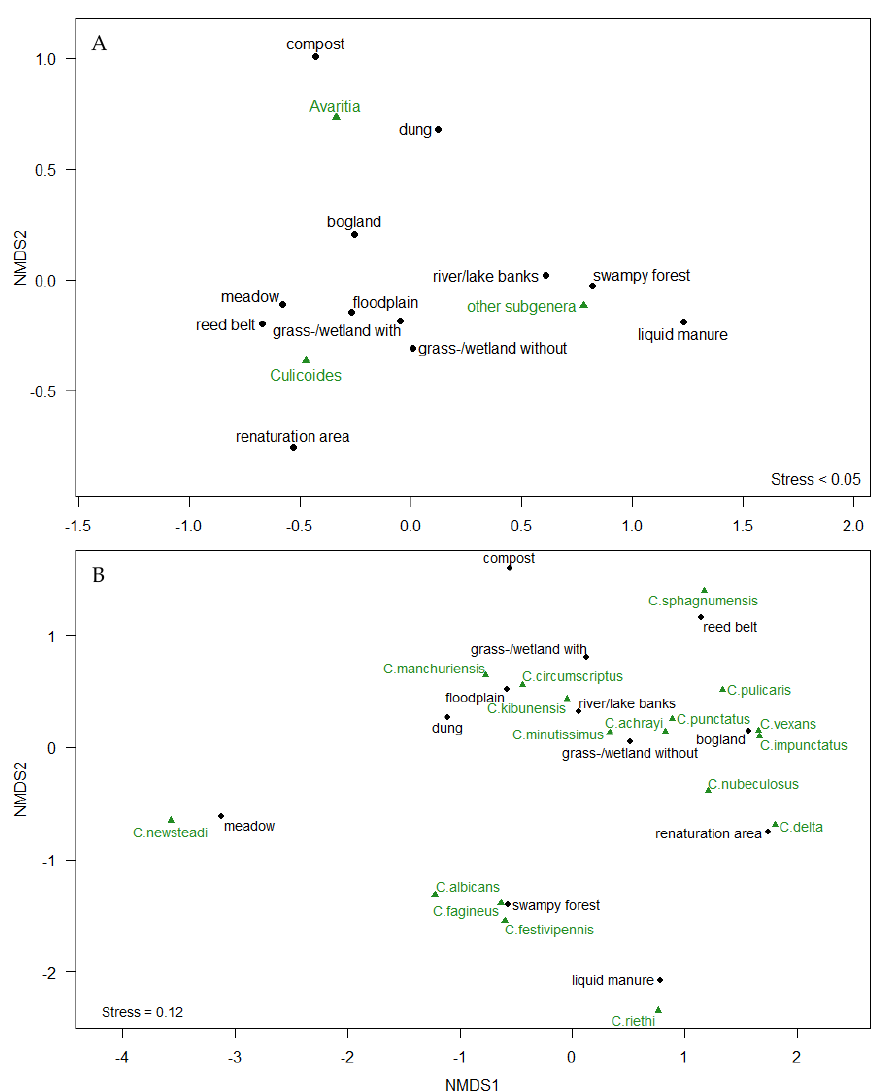
Figure 2. Two-dimensional NMDS ordination plot of habitat preference by culicoid subgenus/group ( A ) and species ( B —subgenus Avaritia excluded for species). Distance of habitats (black points) to biting midge subgenus and species (green triangles) are a measure of habitat preference. Abbreviations of landscape/habitat types: grass-/wetland without — mixed grassland/wetland